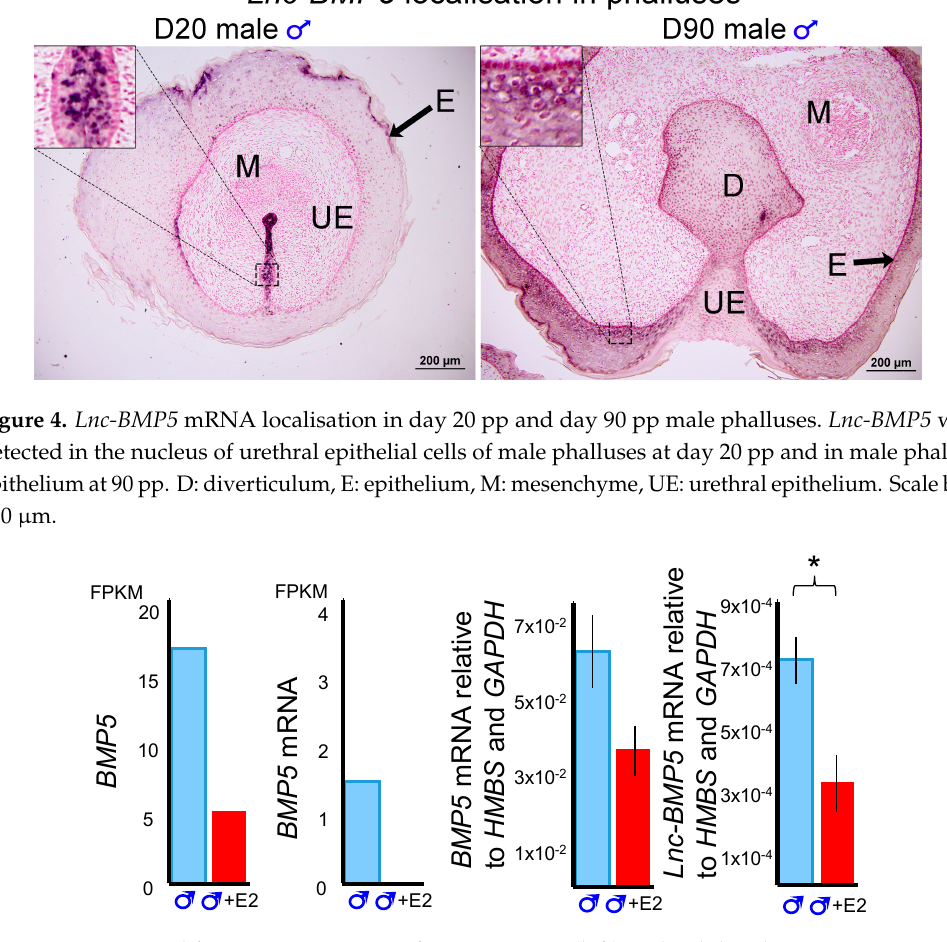
Figure 5. BMP5 and lnc-BMP5 expression from RNA-Seq (left) and validated in quantitative PCR (qPCR) (right). BMP5 and lnc-BMP5 was downregulated by oestrogen in males. E2: oestrogen. FPKM: Fragments Per Kilobase of transcript per Million mapped reads. *: p < 0.05, ***: p < 0.001. Error bar: SEM. Lnc-ZBTB16 and ZBTB16 were significantly downregulated after oestrogen treatment (Figure 6). Lnc-RSPO4 was located within 1 kb upstream of R-Spondin 4 ( RSPO4) (Figure S1). Lnc-RSPO4 and RSPO4 had similar qPCR and transcriptome expression patterns (Figure 6). Lnc-RSPO4 was significantly down-regulated after adiol treatment (Figure 6). Although RSPO4 expression was not as significantly changed as that of lnc-RSPO4 , the expression correlation between RSPO4 and lnc-RSPO4 was